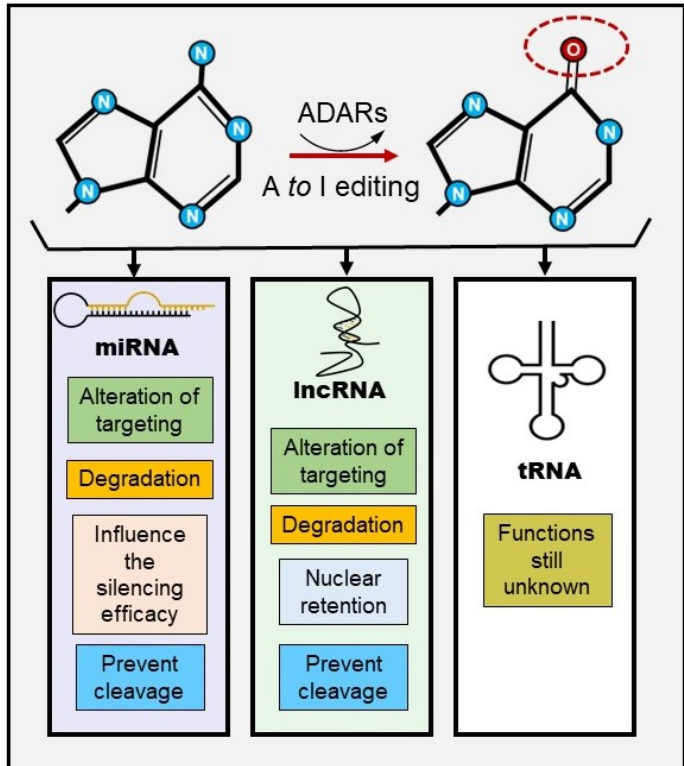
Figure 3. ncRNAs A-to-I biological consequences.